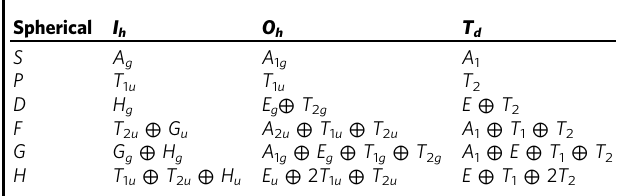
Table 1 Splitting patterns of superatomic orbitals